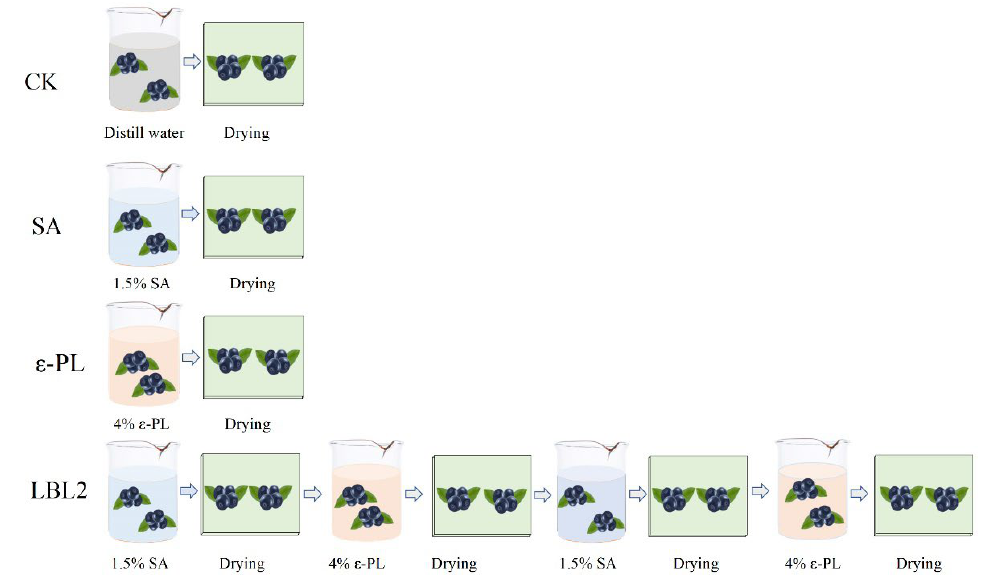
ε -PL, and LBL2 Figure 2. Schematics of CK, SA, ε -PL, and LBL2 treatments. Figure 2. Schematics of CK, SA,